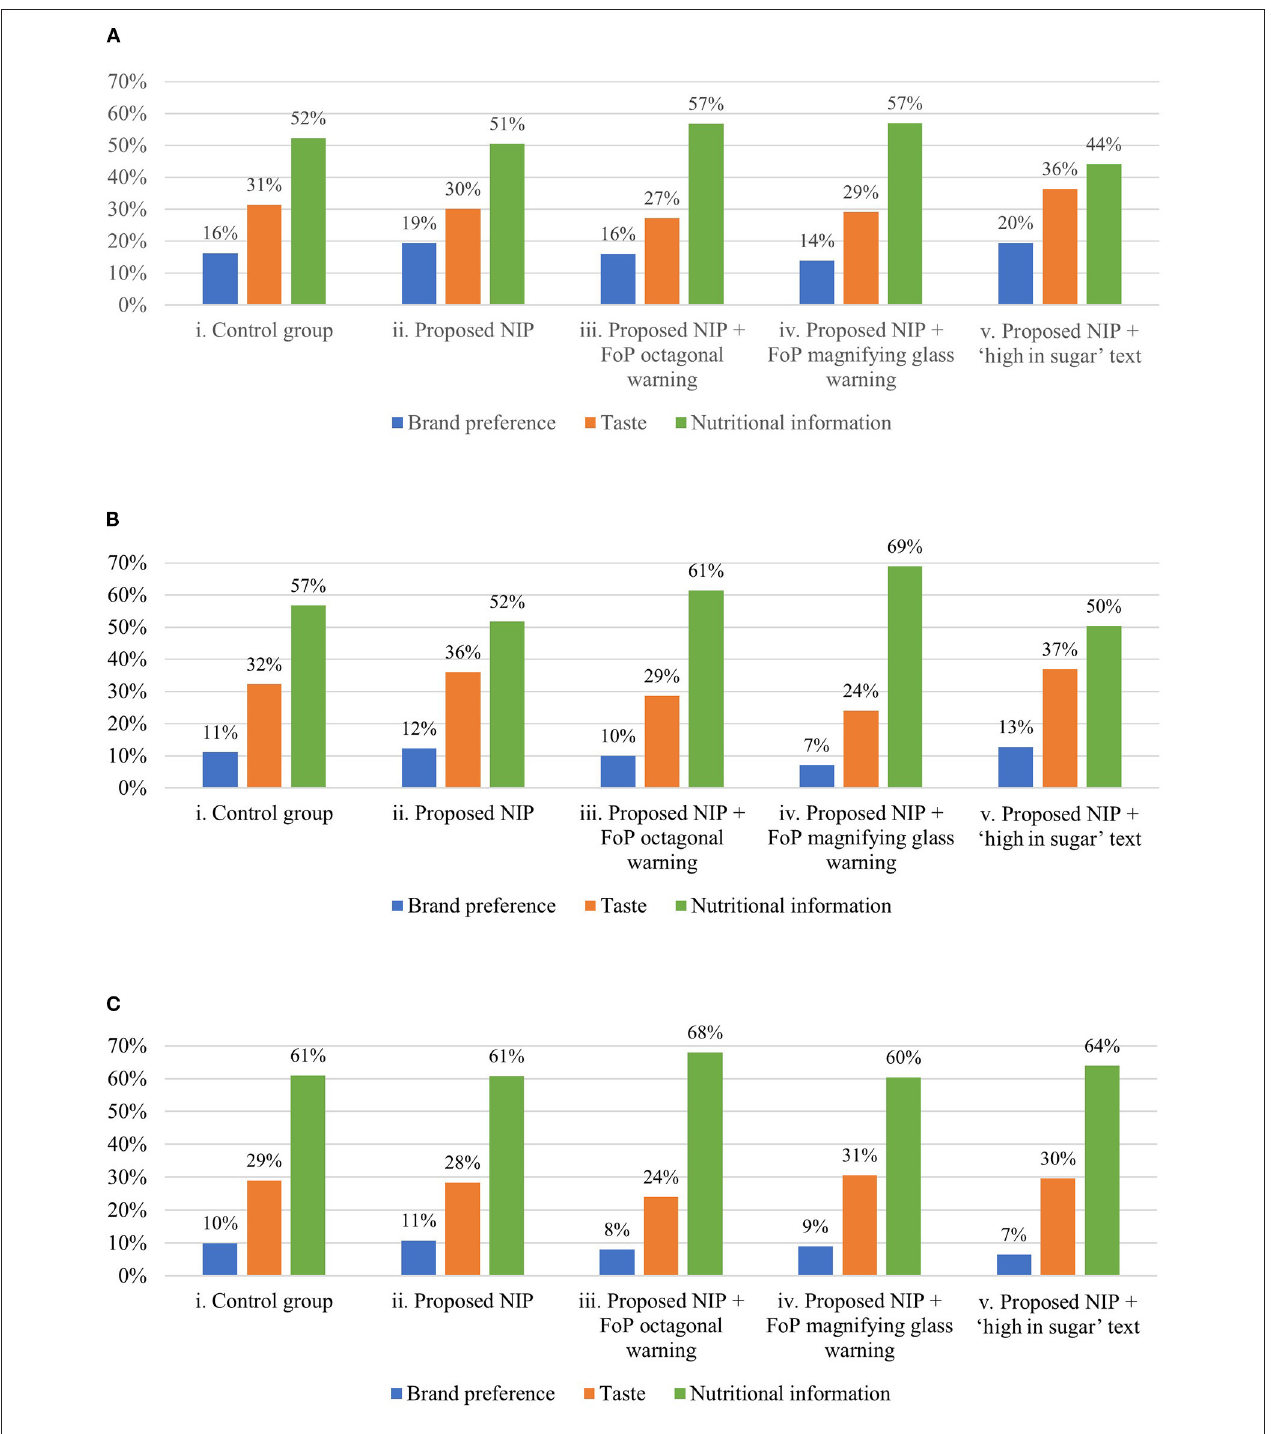
FIGURE 3 | Proportional distribution of each reason for participants’ food choices, by food category. (A) Reason of product’ choice: whole-grain biscuit. (B) Reason of product’ choice: cereal bar. (C) Reason of product’ choice: yoghurt. NIP, Nutrition Information Panel. FoP, Front-of-Package.